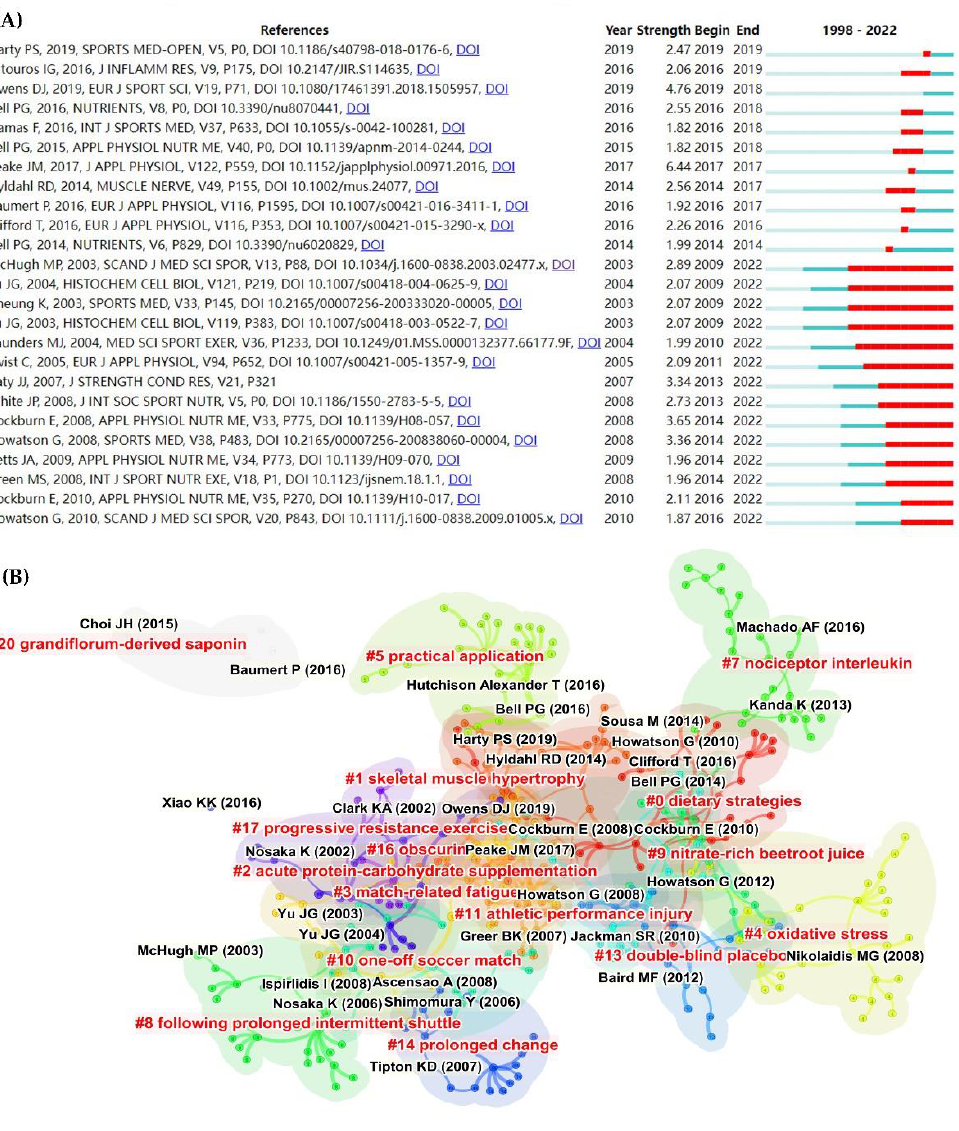
Figure 6. The visualization of the co-citation network and information on the top ten co-cited journals. ( A ) The network map of co-cited journal collaboration and ( B ) discipline categories. Black font indicates representative co-cited references; red font with # indicates cluster labels and cluster names of co-cited references [1 – 28,31,33,34,36,38 – 67].